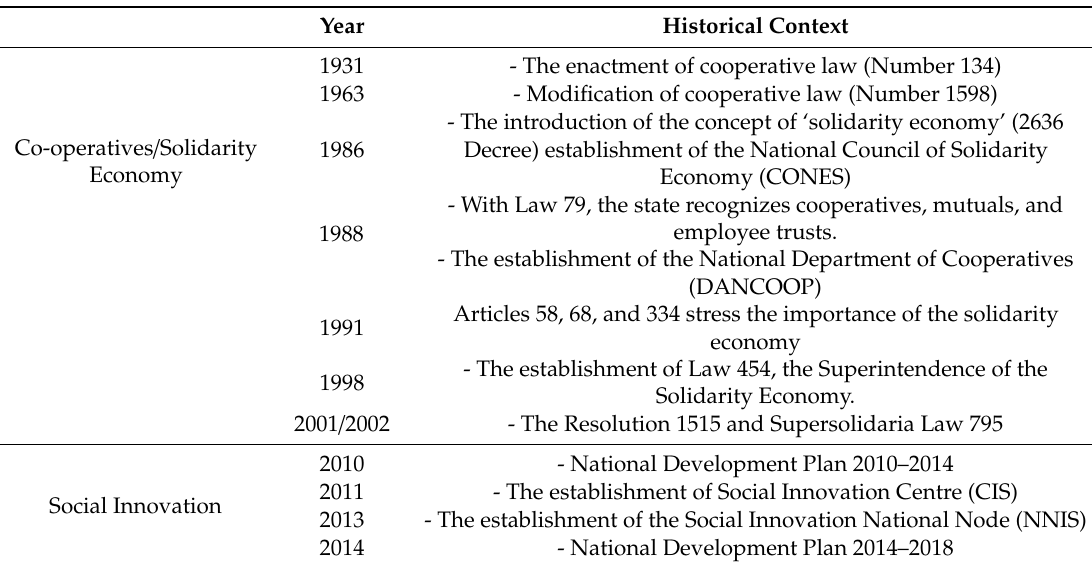
Table 4. Institutional framework for SSEI initiatives in